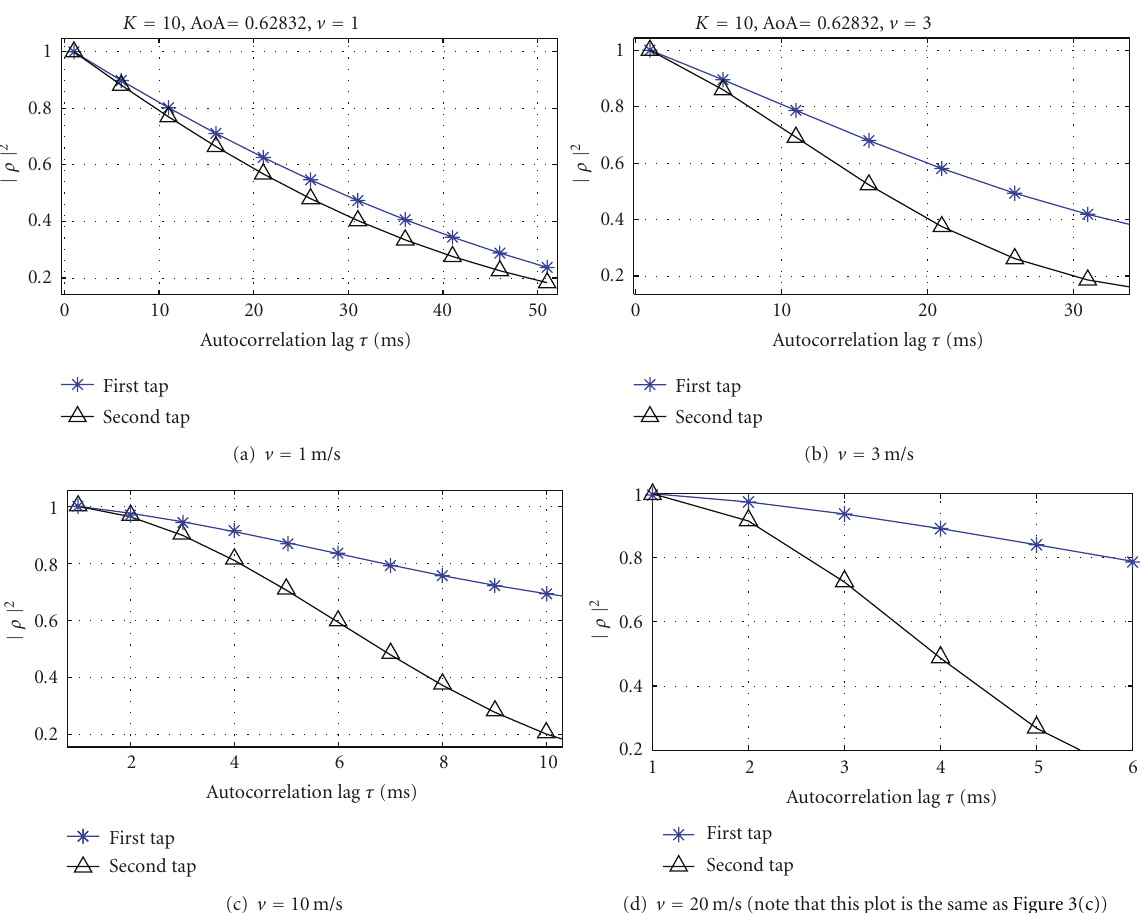
(d) v = 20m/s (note that this plot is the same as Figure 3(c))